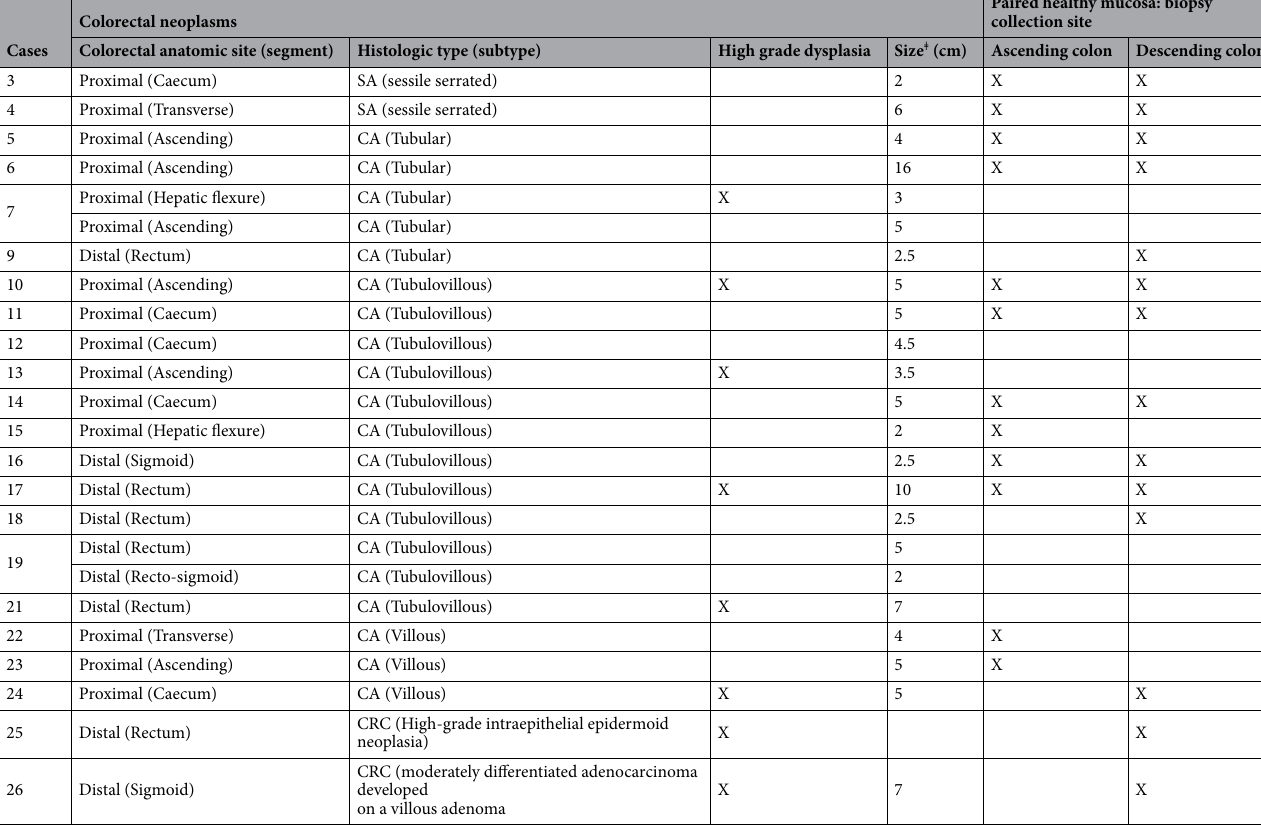
Table 3. Characteristics of colorectal neoplasms in case group. SA Serrated adenoma, CA Conventional adenoma, CRC colorectal cancer, X applicable. ǂ The largest diameter is reported.